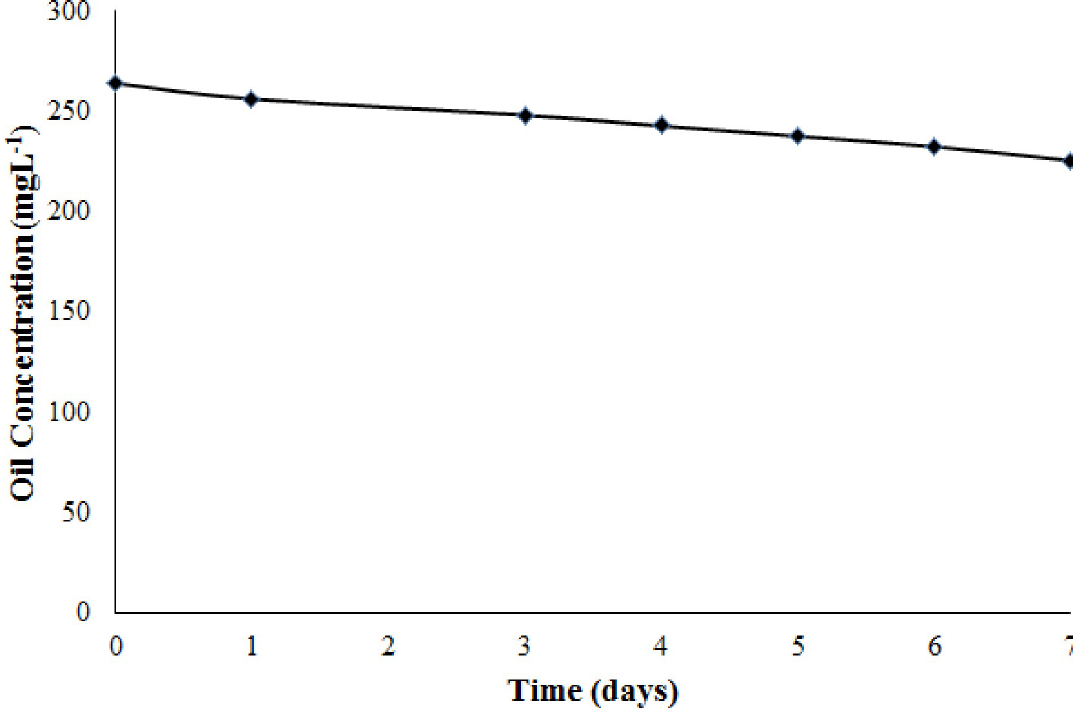
Fig 8. Stability of crude O/W emulsion over the